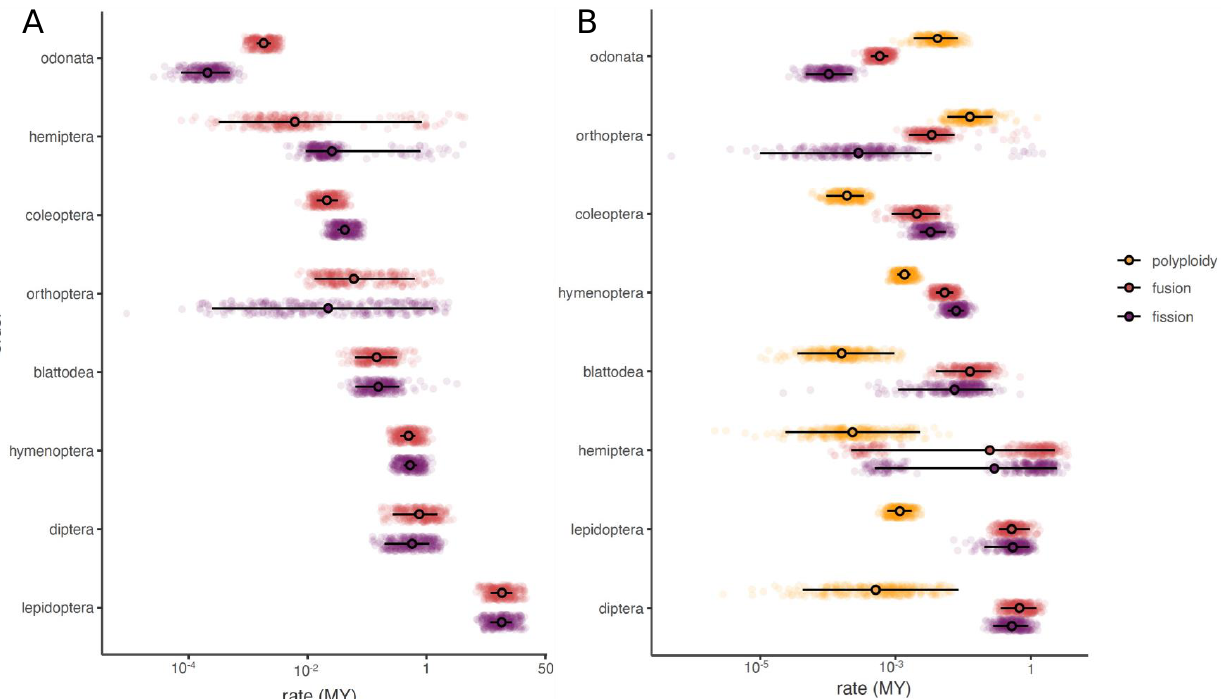
Figure 2. Rates of chromosome evolution in insect orders. In each plot, we show the distribution of the estimated rates for each order of insects included in the study. Rates of chromosome evolution are plotted on a log scale, but unlogged values are shown at the tick marks for ease of interpretation. The credible interval for each statistic is shown as a black line while the mean is indicated with a black circle. ( A ) simple model with fissions and fusions. ( B ) complex model with fission, fusions, and polyploidy. The insect clades are ordered by mean rate in chromosome evolution.